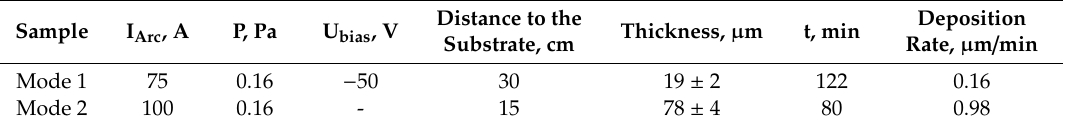
Table 1. Deposition